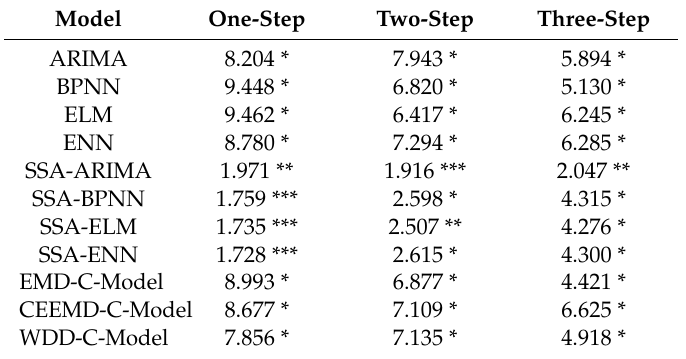
Table 8. Diebold–Mariano (DM) test results for the developed model and comparison